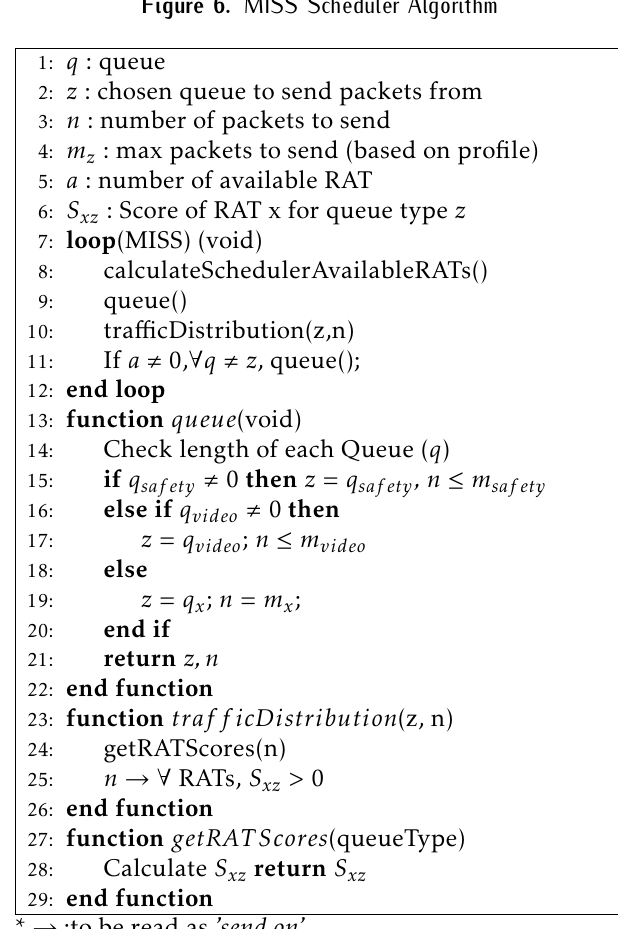
Figure 6. MISS Scheduler